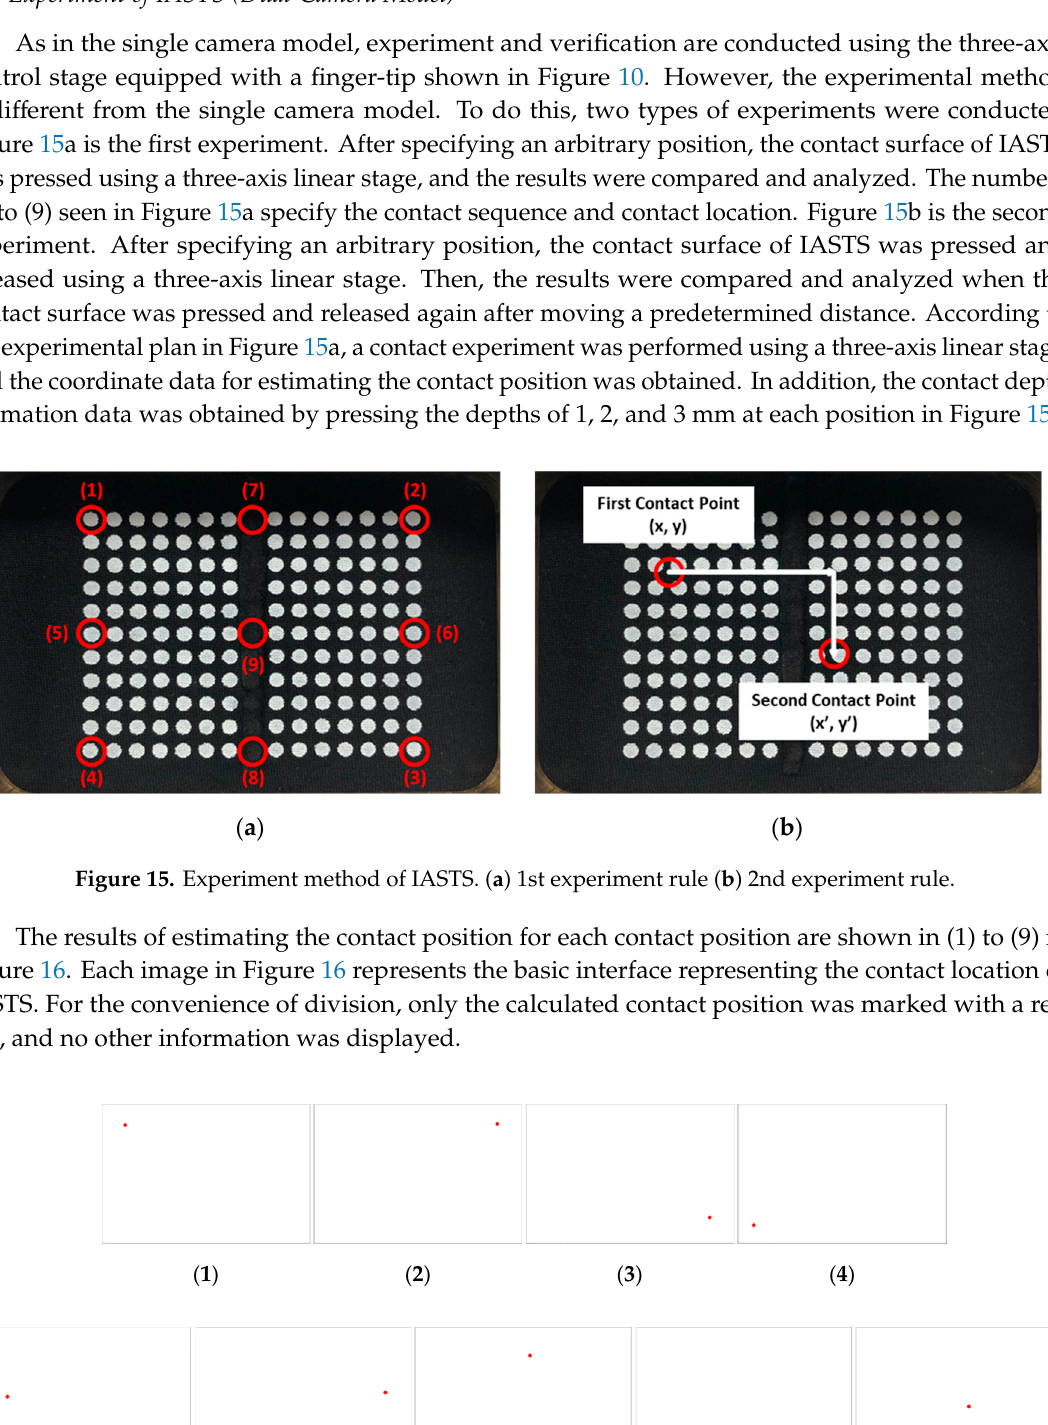
Figure 16. Experiment 1 for proposed system and algorithm verification ( 1) when pressing the upper left corner (2) when pressing the upper right corner (3) when pressing the bottom right corner (4)